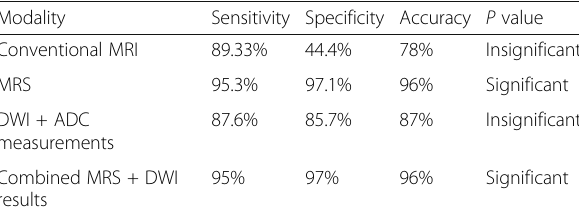
Table 7 Sensitivity, specificity, and accuracy of conventional MRI, MRS, and DWI with ADC values for all studied lesions